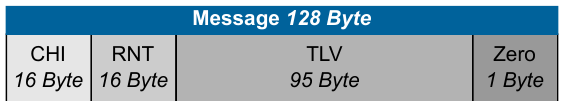
Figure 1. Format of the plain message x which will be processed by the RAMON crypto system.